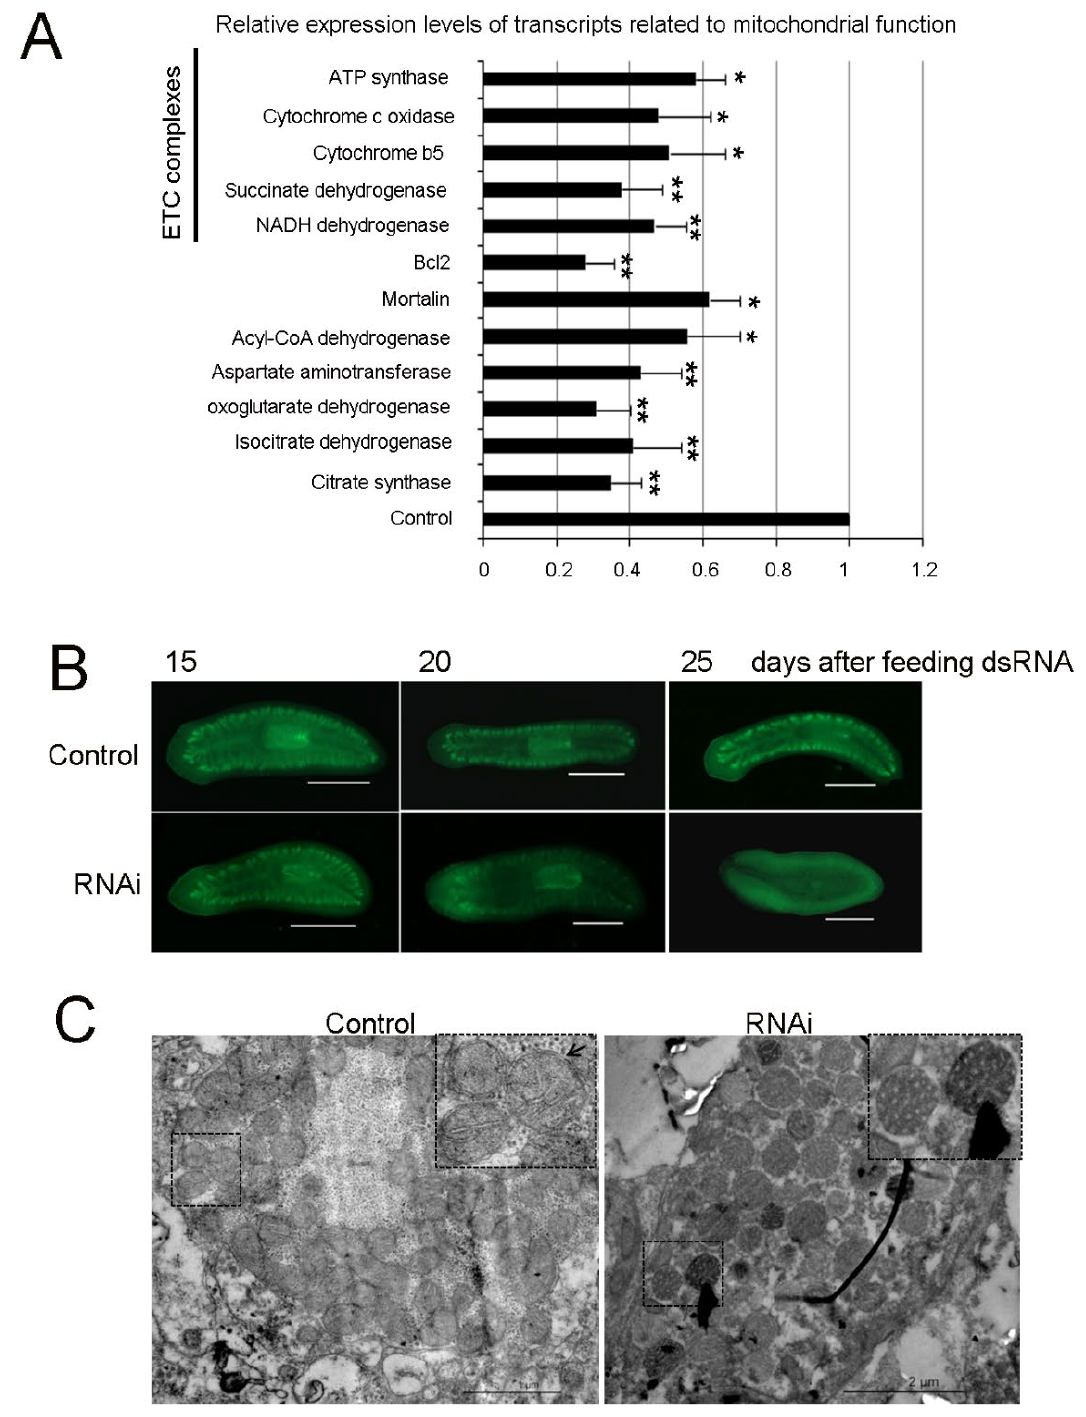
Figure 8. Mitochondrial function is severely impaired by RNAi- Djhsp60 . ( A ) Relative expression levels of transcripts-related to mitochondrial function detected by qPCR. Asterisks indicate statistical differences (* p < 0.05, ** p < 0.01). ( B ) Assessment of mitochondrial respiration after the feeding of dsRNA revealed by H 2 DCFDA staining. Ventral views, n = 5 animals. Scale bar: 1 mm. ( C ) Ultrastructure of mitochondria revealed by TEM. Honeycomb-like mitochondria occurred in RNAi animals. Double membrane layers were indicated by black arrow.